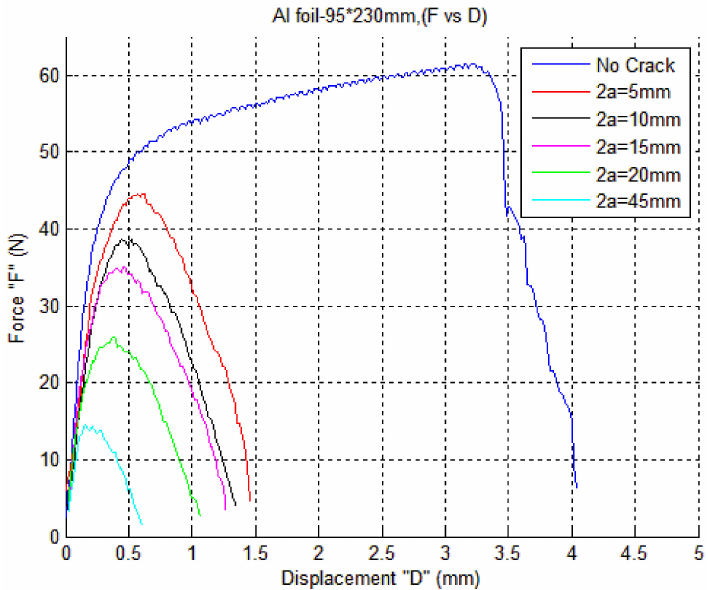
Figure 7. Load vs. displacement of Al foil (center cracked) of 0–45 mm. Table 2. Load and displacement of fractured Al foil, thickness B of 9 µ m and dimensions of 230 mm × 95 mm. Crack Length